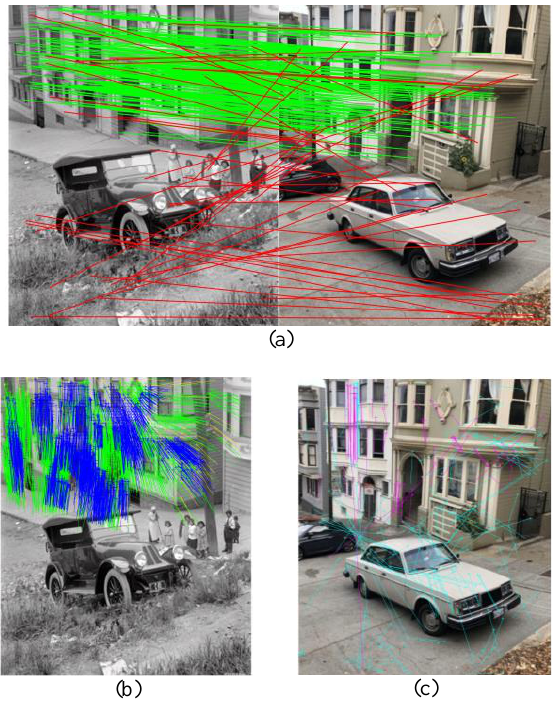
Figure 3: Evaluation on the San Francisco image pair. (a) an example of valid (green) and invalid (red) matches, in the specific case for DISK with DEGENSAC; (b) sparse optical flow for hand-taken ground-truth matches (yellow) and detected correct matches (green, blue); (c) detected wrong matches (cyan, magenta) that also satisfy the epipolar error constraints. More in detail, the epipolar error threshold was set to 15 px, as well as the threshold to define the optical flow consistency, while local homographies reprojection error was fixed to 5